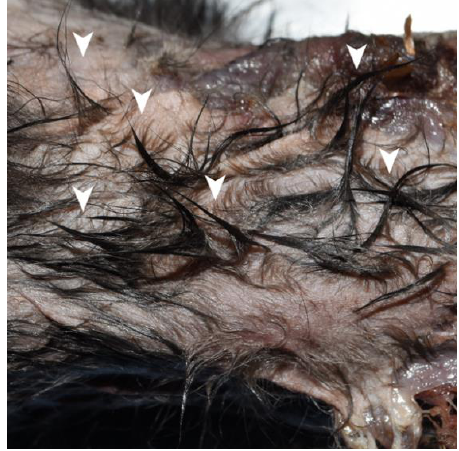
Figure 4. Hair tufts in a cat carcass. Hair tufts (arrowheads) are presumably stuck together by the saliva of the attacker.